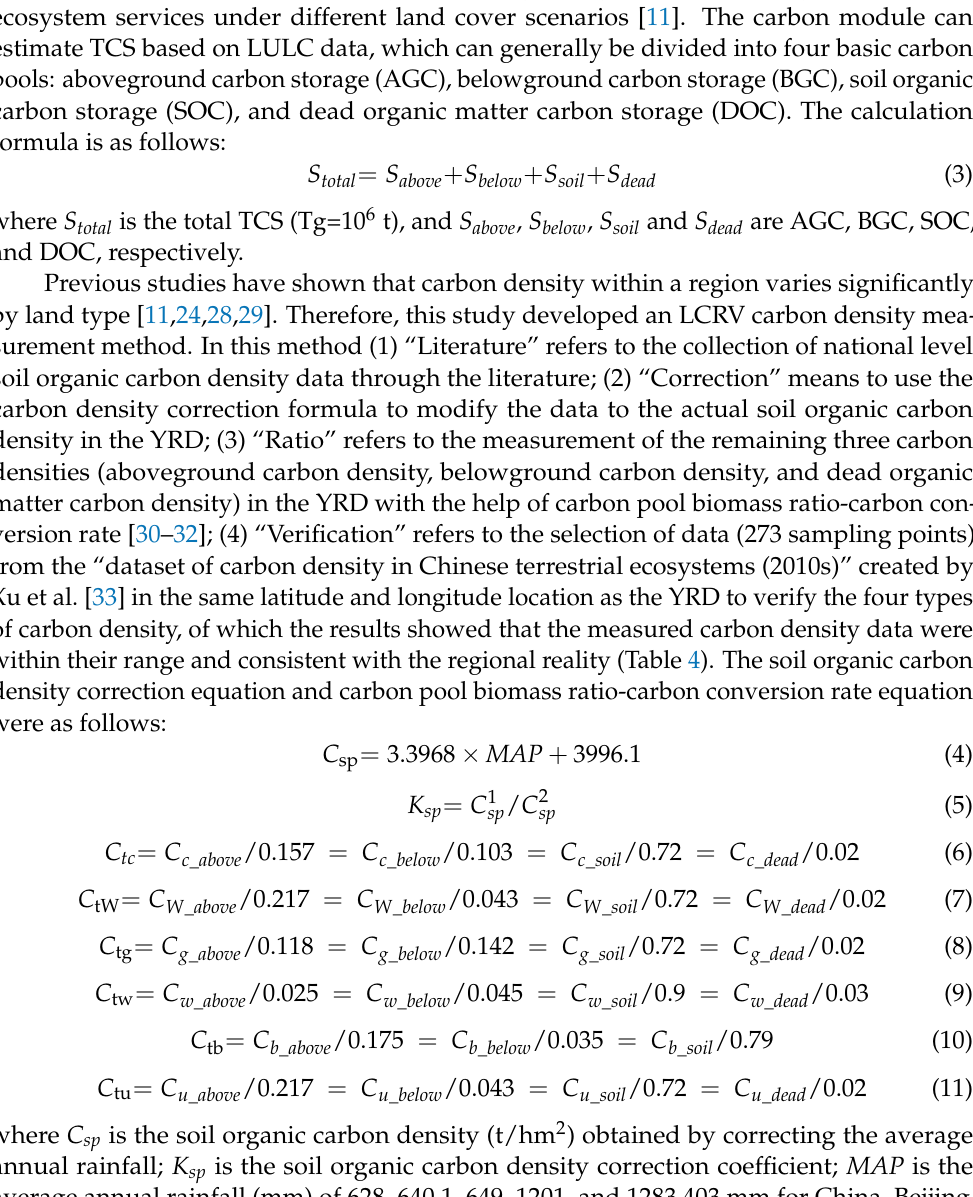
Table 3. The number of demand for each land use type in different scenarios in the YRD in 2030 (km 2 ). Scenario Cropland Woodland Grassland Waterbody BS 163,597 99,917 10,870 23,673 49,688 255 CP 164,664 100,250 10,683 23,098 49,045 260 EP